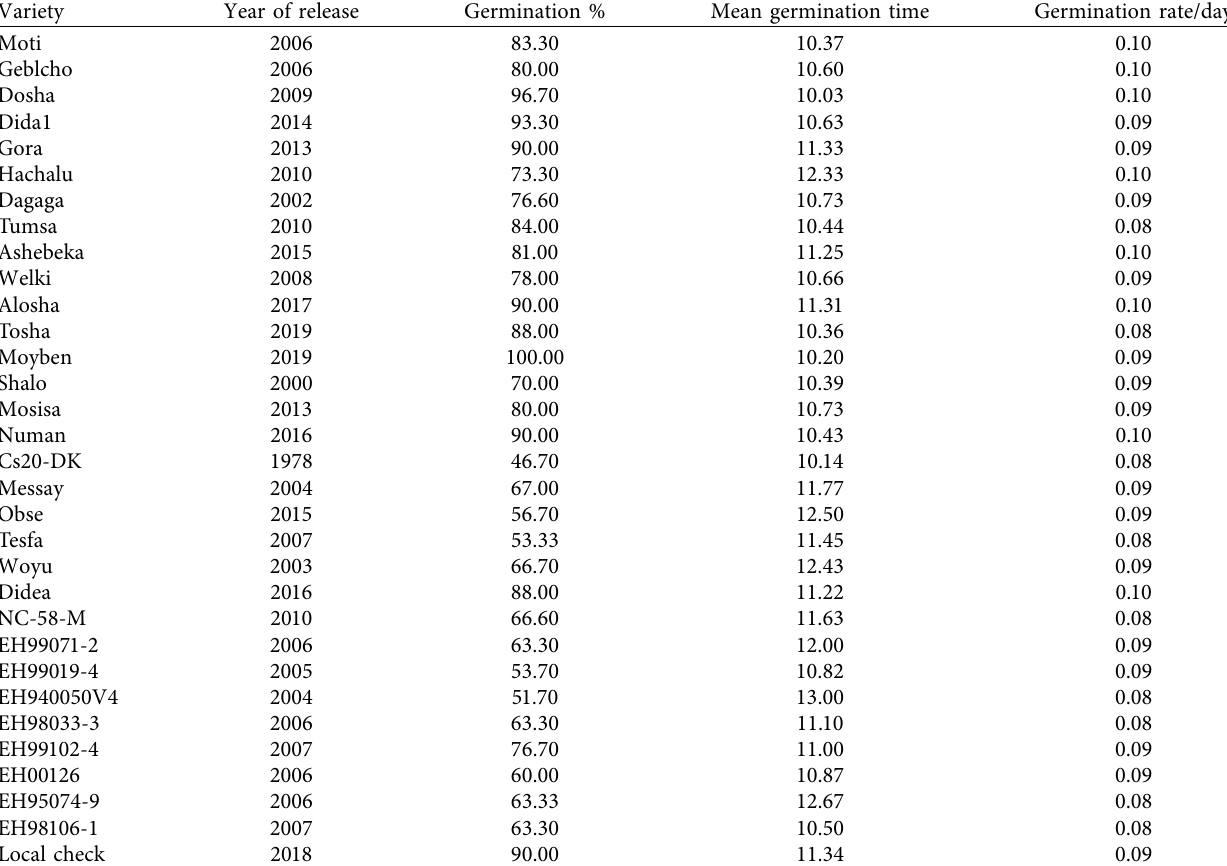
Table 4: Percent of germination, mean germination time and germination rate of the tested faba bean genotypes. Variety